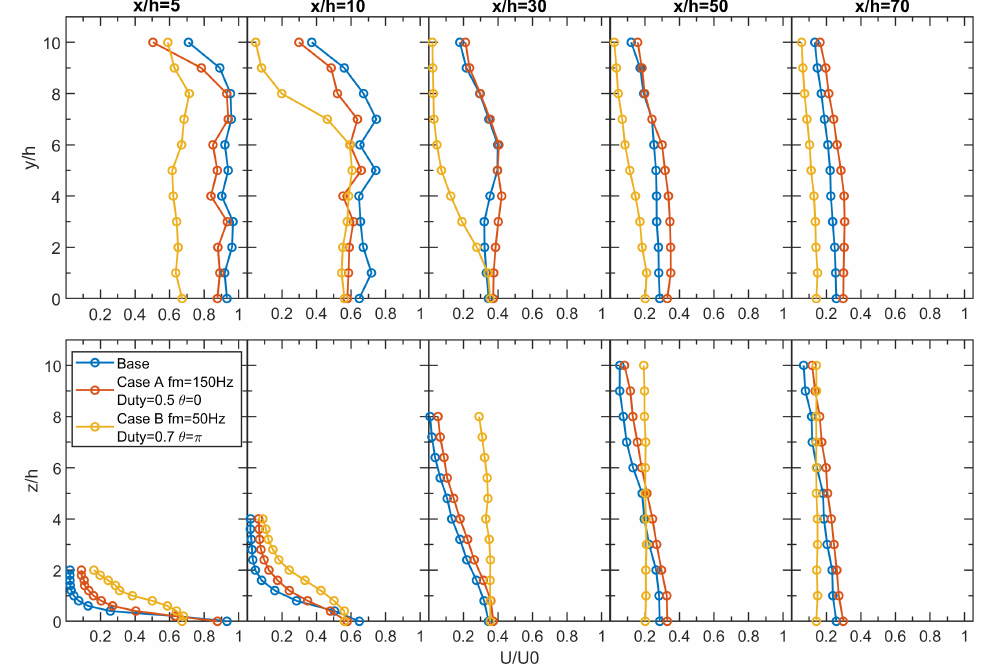
Figure 16. Velocity distribution along the oy and oz directions at different